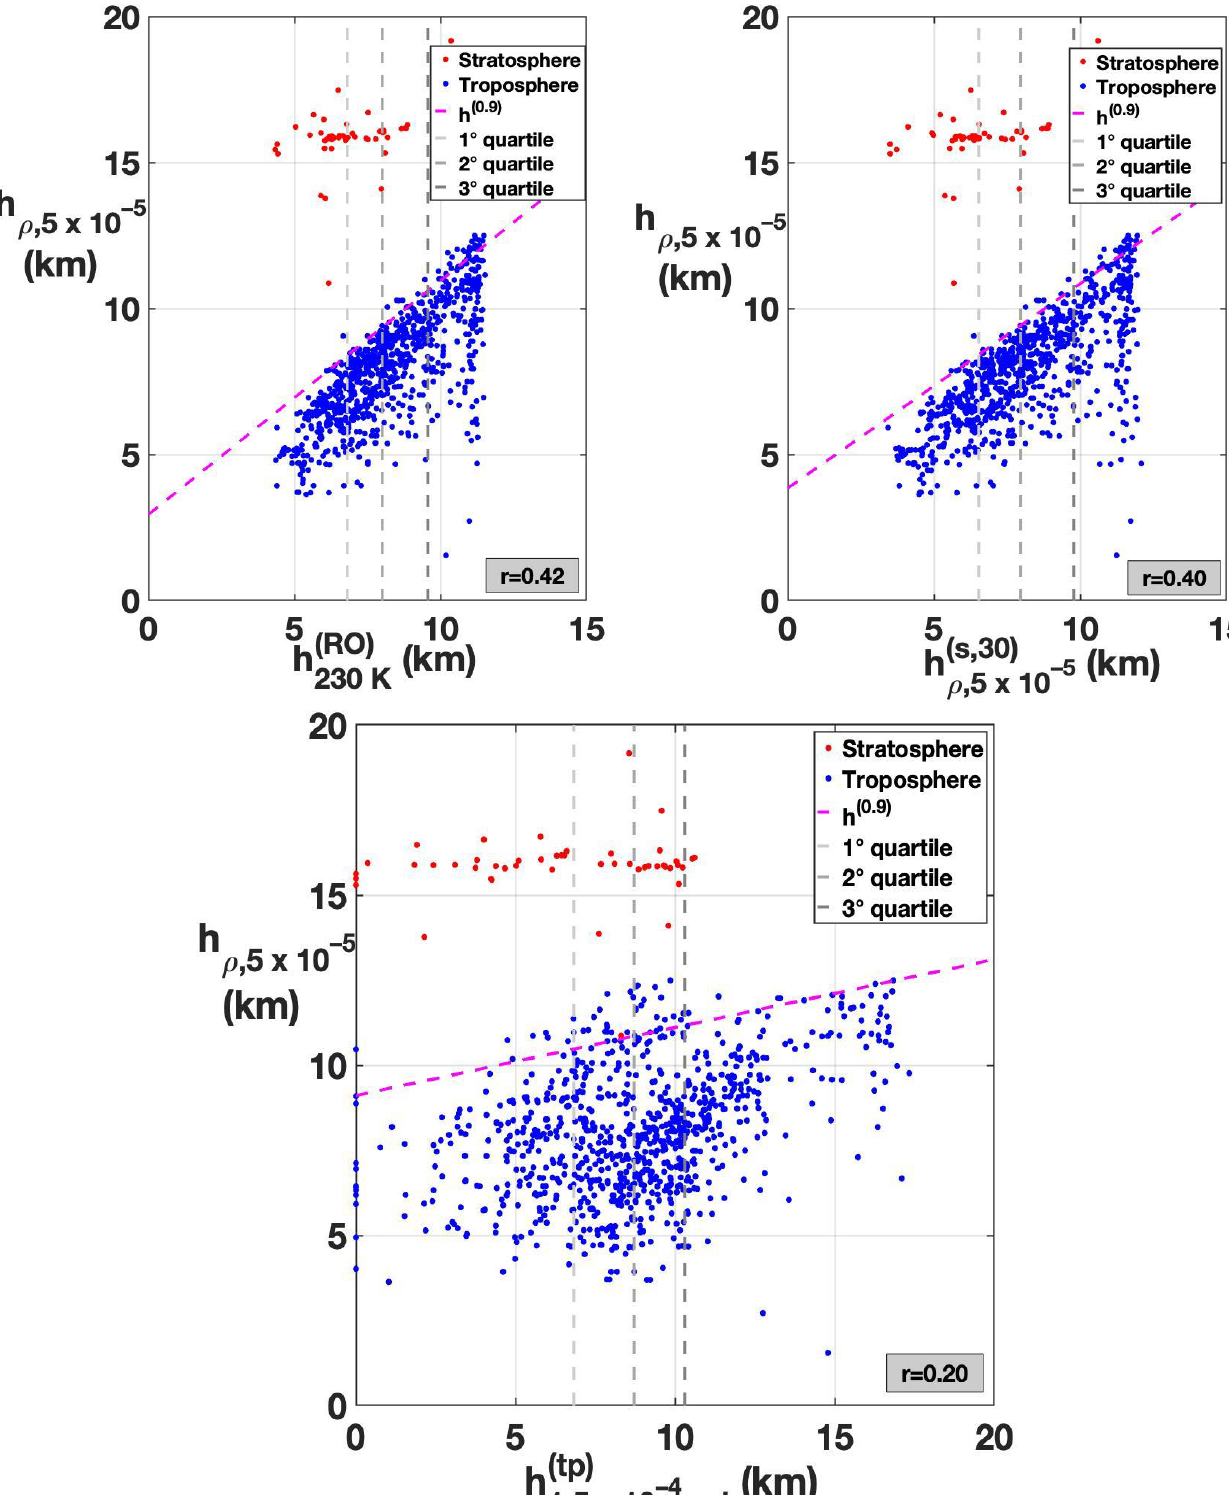
( RO ) ( top left ), 230 K K(𝑅𝑂) ( top left ), 230